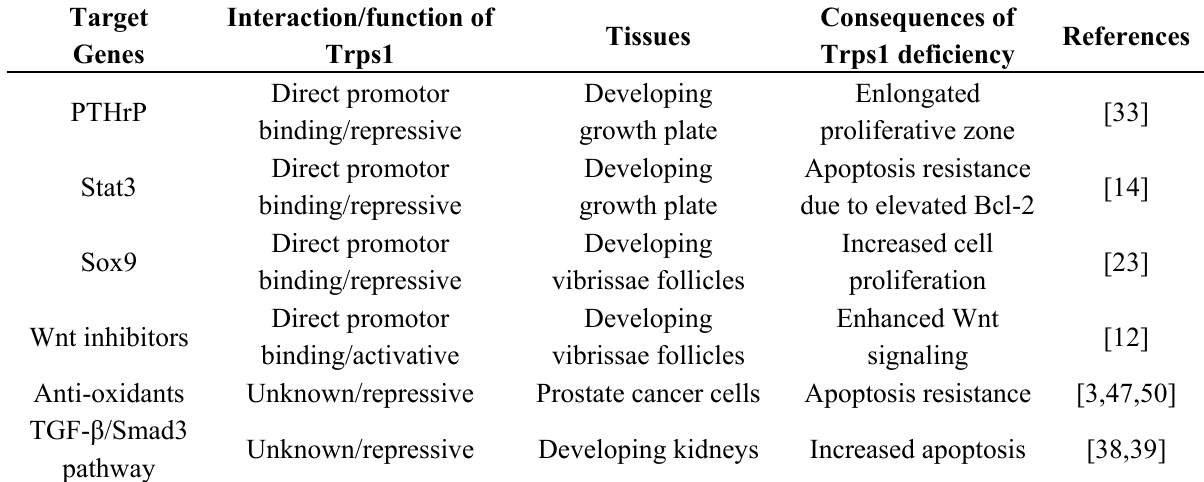
Table 1. Target genes of tricho-rhino-phalangeal syndrome (Trps) 1, interaction and function of Trps1, the tissues where the interaction with Trps1 takes place, and the consequences of the